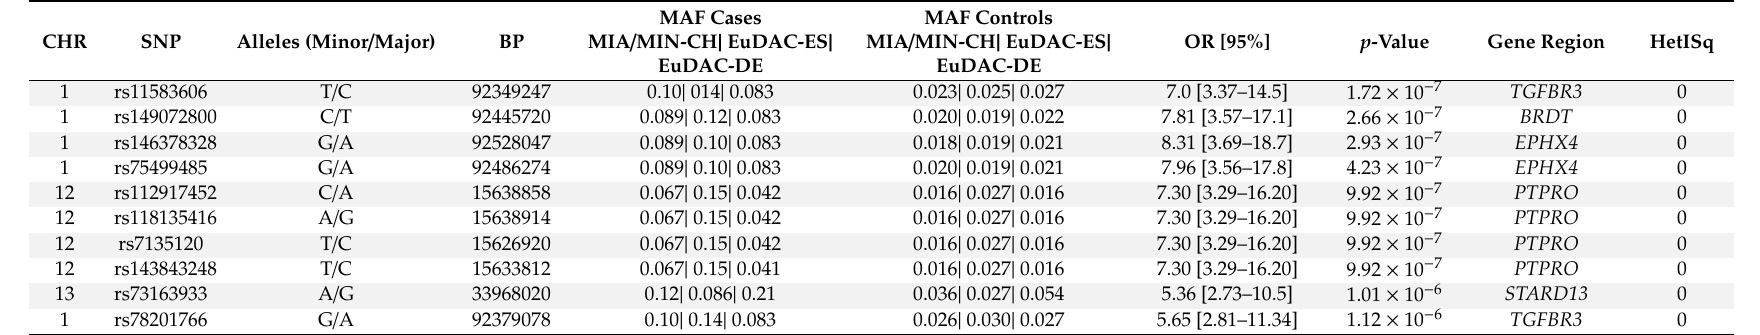
Table 3. Top associations of the GWAS meta-analysis in MIA cases versus controls in the three independent European cohorts. Top GWAS meta-analysis results based on approximately 7 million SNPs after imputation in 71 MIA cases vs. all 464 controls (tolerant and unexposed). All results were adjusted for four genetic multidimensional scaling (MDS) components and sex (only for EuDAC-ES). Chromosomal location is according to the Genome Reference Consortium human